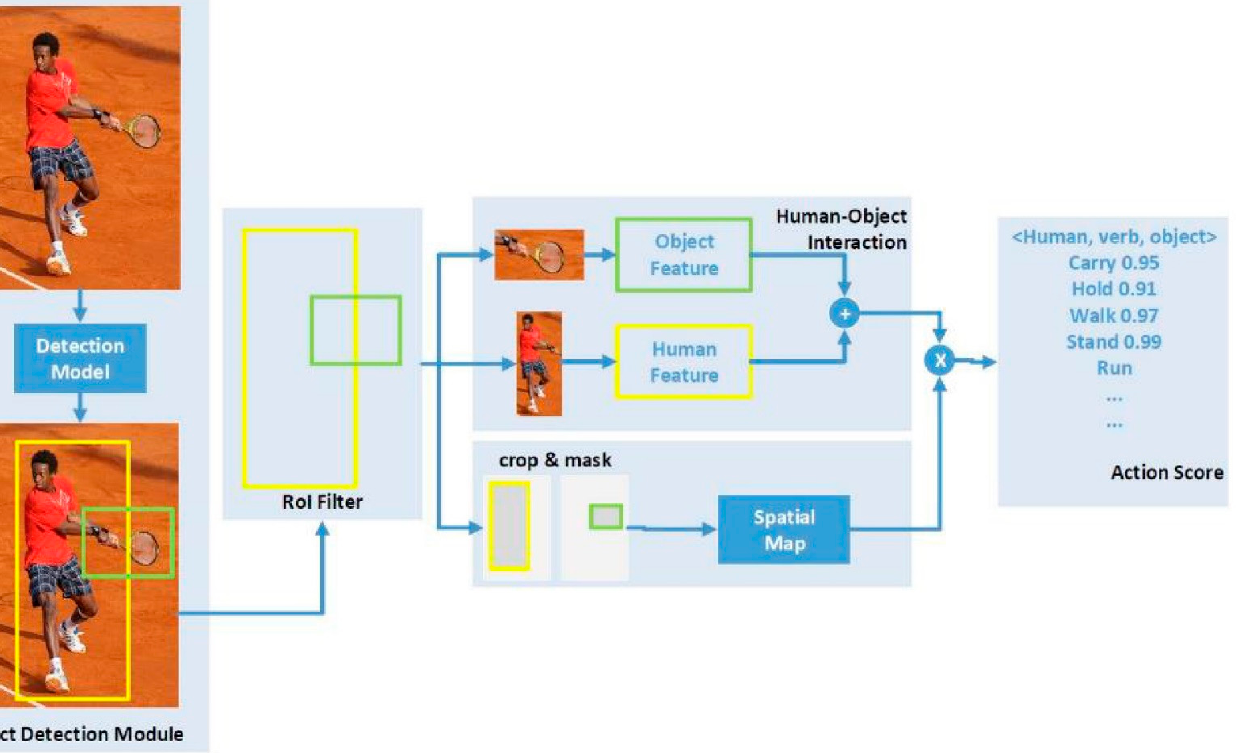
Figure 8. Human–object interaction pipeline architecture.